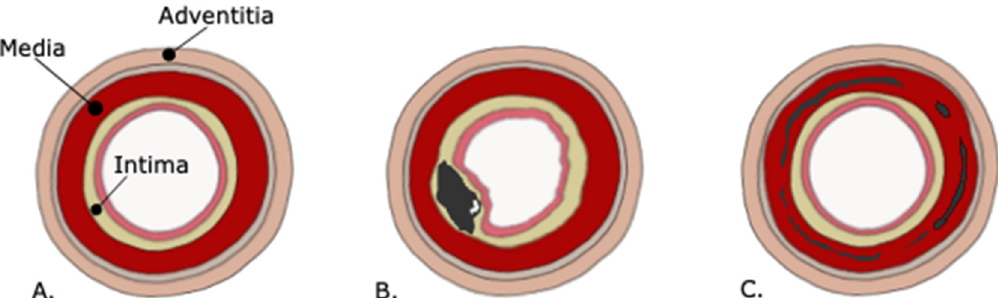
Figure 1. ( A ) Wall layers in a normal artery from inside to outside: endothelium, tunica intima (internal elastic membrane and fibrocollagenous tissue), tunica media (smooth muscle), tunica adventitia (external elastic lamina and fibrocollagenous tissue). ( B ) Calcifications in the intimal wall: thick and non-annular. ( C ) calcifications in the medial wall and in the internal elastic lamina: thin and annular.